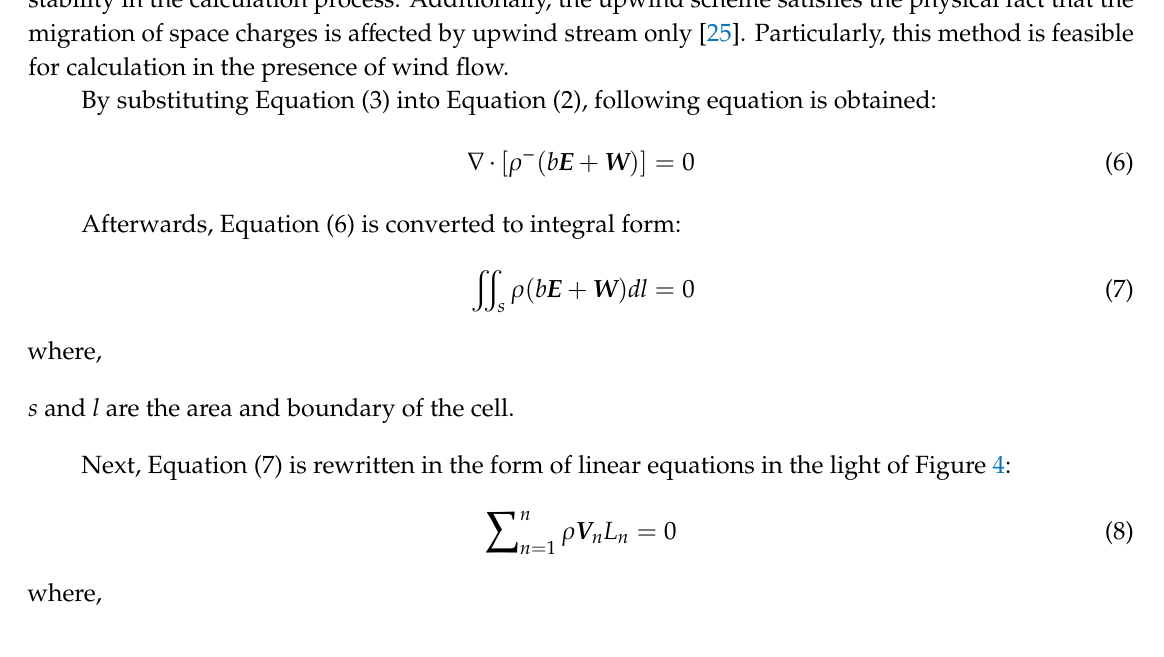
Figure 3. CSM method.